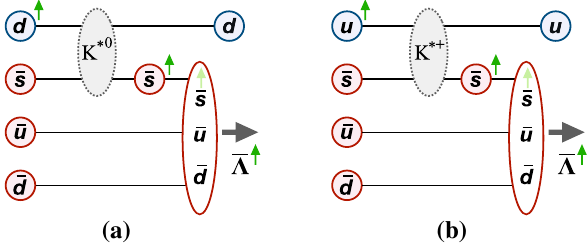
Fig. 2 Polarizationofalightquarkistransferred,inaninelasticscatter- ing via an intermediate vector kaon state – for example, via a K ∗ 0 = d ¯ s and b K ∗+ = u ¯ s – to an anti-strange quark and then to a final anti- hyperon ¯ (cid:4) . Hyperons (cid:4) acquire their polarization from spin-polarized light anti-quarks in the C -conjugated processes (not